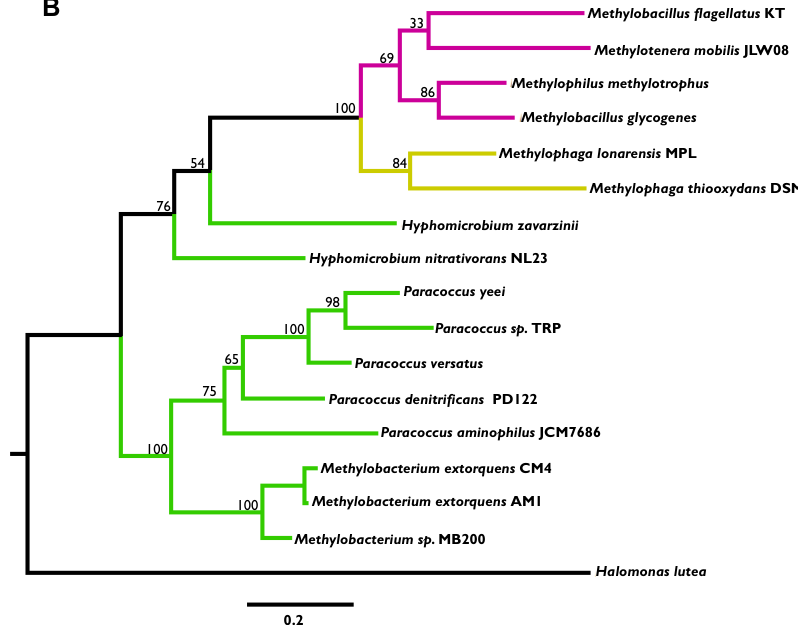
Figure 4. ( A ) A maximum likelihood phylogeny of the mauB amino acid sequence (encoding the large subunit of methylamine dehydrogenase) from sequenced methylotrophs of the Alpha—(green), Beta—(pink), and Gamma—(yellow) Proteobacteria using the mauB sequence from Halomonas lutea as an outgroup. ( B ) A maximum likelihood phylogeny of the mauA amino acid sequence (encoding the small subunit of methylamine dehydrogenase) from sequenced methylotrophs of the Alpha—(green), Beta—(pink), and Gamma—(yellow) Proteobacteria using the mauA sequence from Halomonas lutea as an outgroup. Numbers adjoining nodes represent bootstrap